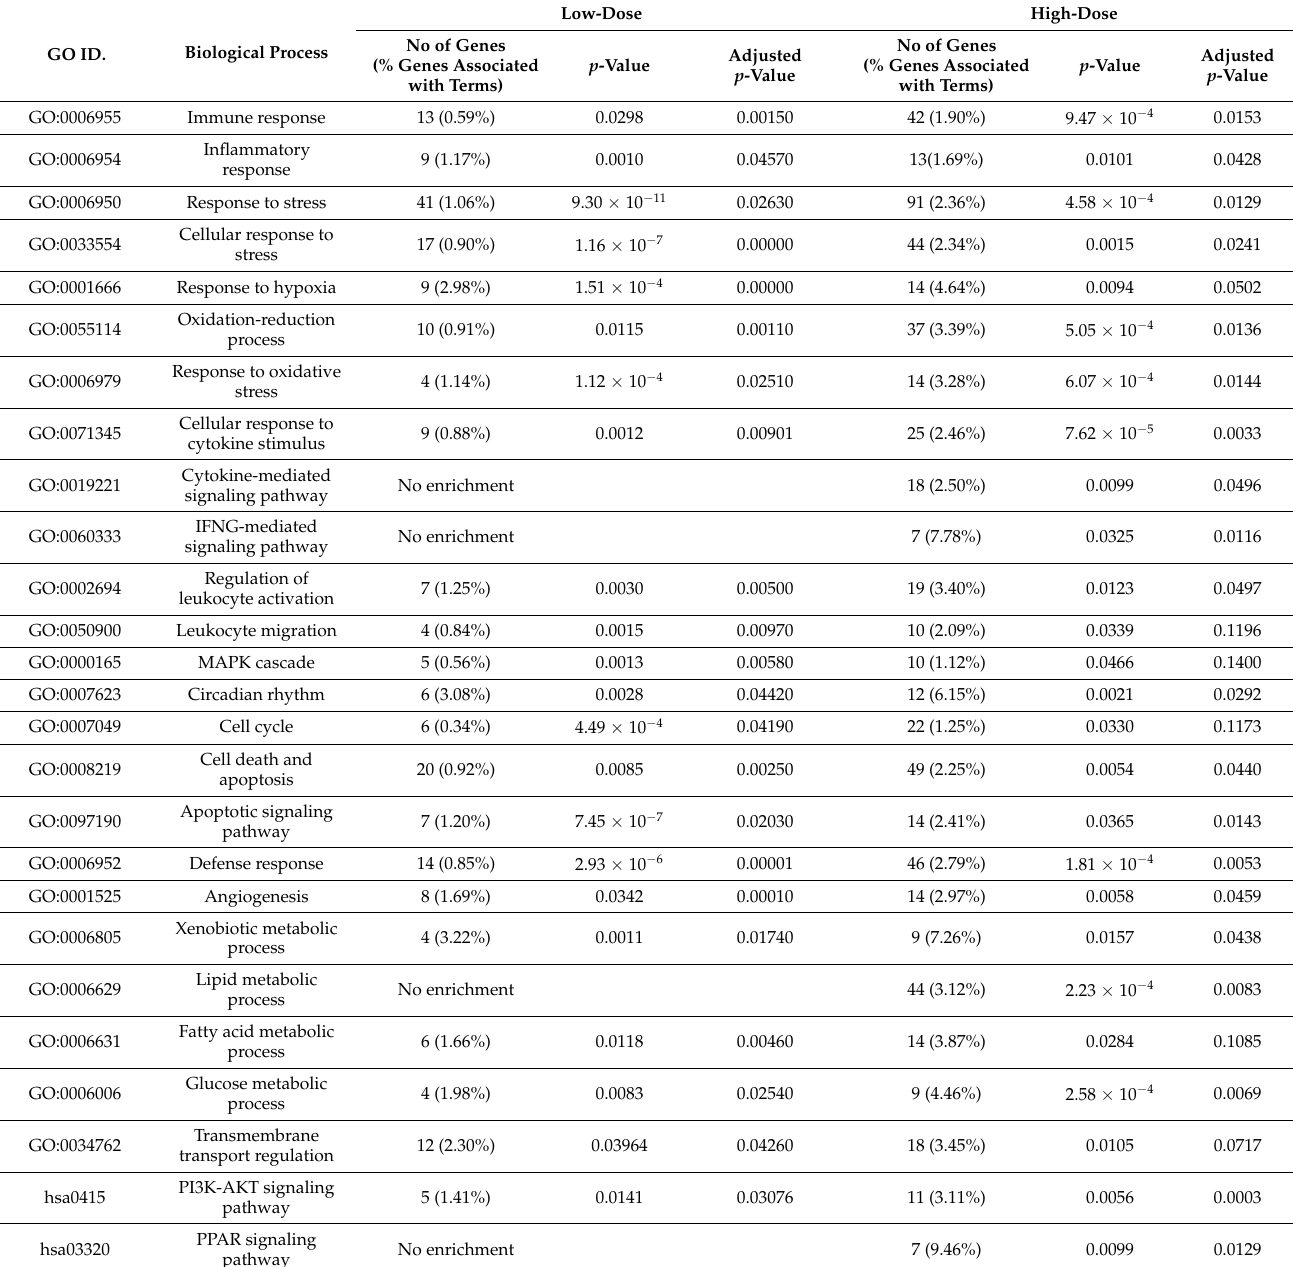
Table 3. Gene ontology enrichment of hepatic DEGs after diclofenac treatment. Gene ontologies were analyzed with the GeneXplain and ClueGO database; significantly enriched biological processes were considered at a p -value < 0.05. The percentage of genes associated with a given biological term and specific pathway were calculated with the AmiGO 2 database (http://amigo.geneontology.org/ amigo/landing, accessed on 4 January 2023) and KEGG repository data